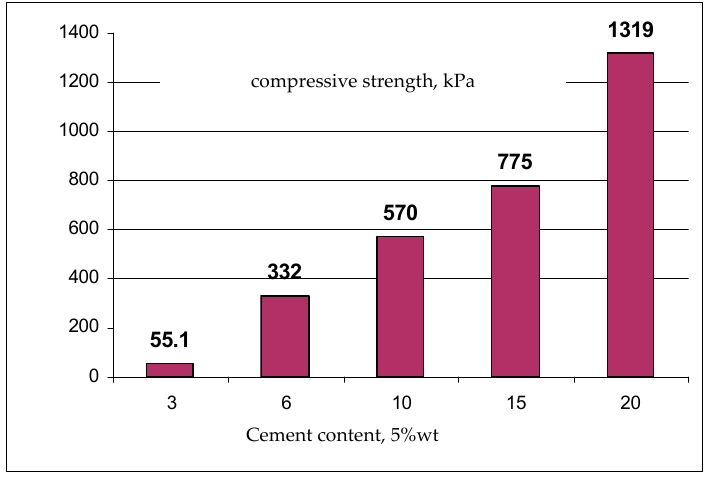
Figure 9. Effect of changes in the amount of cement on the mechanical strength of binder.